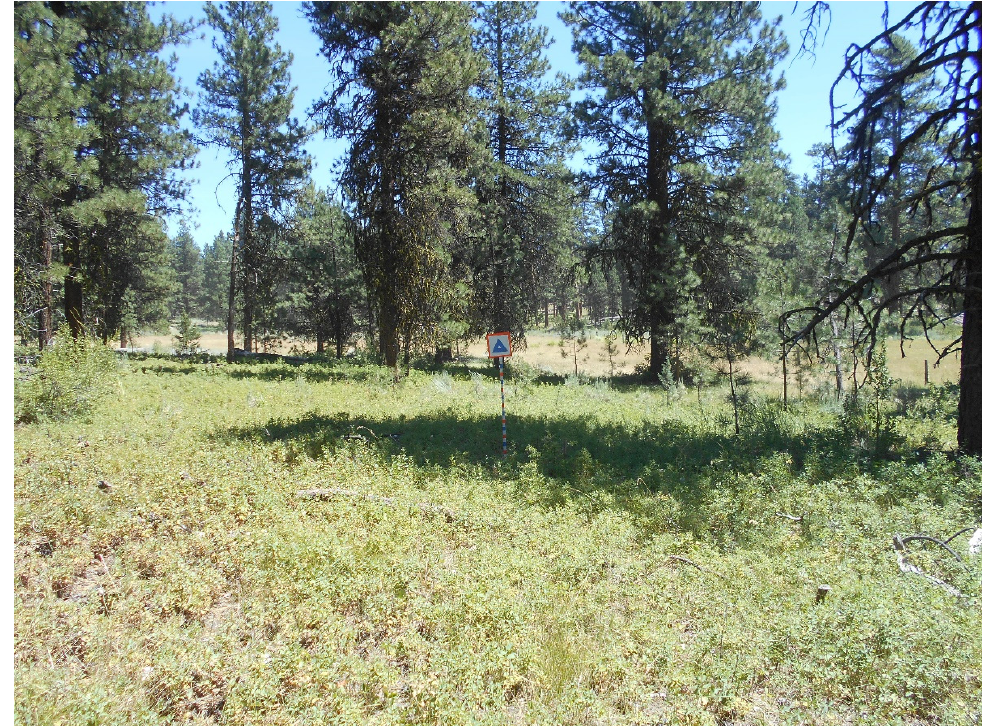
Figure 11. An example ponderosa pine thin-only treatment in eastern Oregon, USA. Surface fuels include abundant vegetation, including some small trees, with older surface fuel accumulations and fresh slash from the thinning treatment.